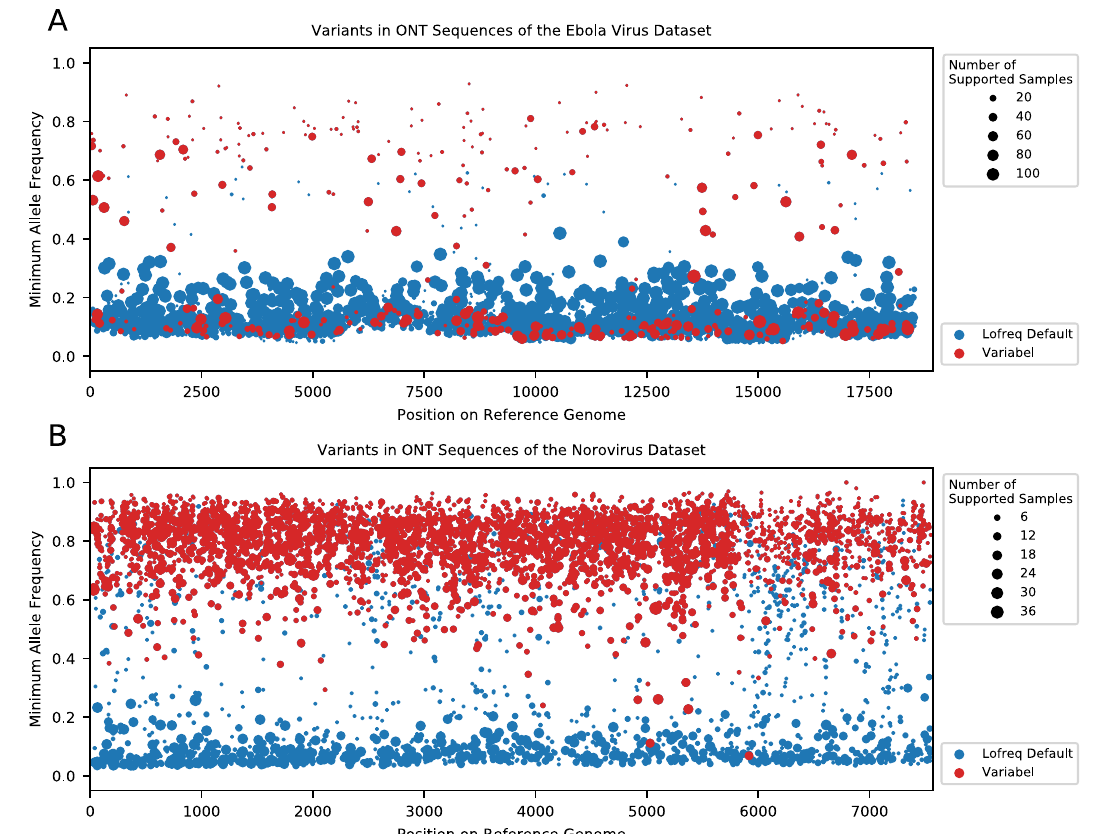
Fig. 5 Intra-host variant detection on Ebola virus and norovirus datasets. A Variant calls before and after fi ltering by Variabel for the Ebola virus dataset. The x -axis shows the positions of the variant calls on the reference genome, and the y -axis shows the minimum allele frequency the same variant calls among the samples. Variant calls before the fi ltering are marked in blue and the variant calls after applying Variabel are marked in red. The size of the dot shows the number of samples in which the variant is detected. B Variant calls before and after fi ltering by Variabel for the norovirus dataset. The x -axis shows the positions of the variant calls on the reference genome, and the y -axis shows the minimum allele frequency the same variant calls among the samples. Variant calls before the fi ltering are marked in blue and the variant calls after applying Variabel are marked in red. The size of the dot shows the number of samples in which the variant is detected. For both A and B , source data are provided as a Source Data fi